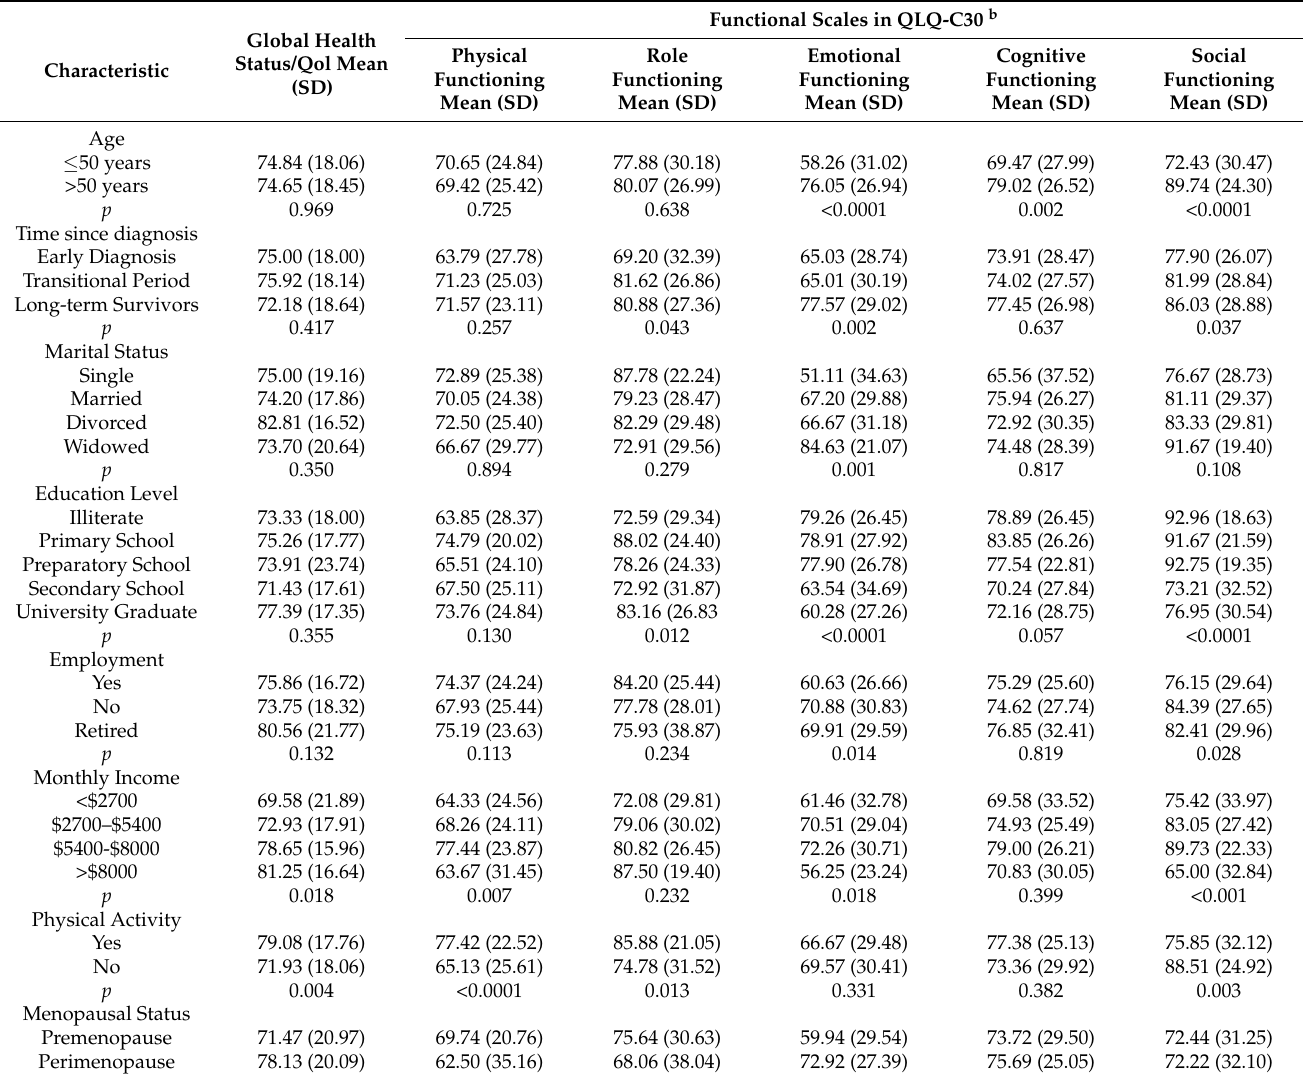
Table 3. Global health and functional scales on the QLQ-C30 by independent variables (N = 250) a